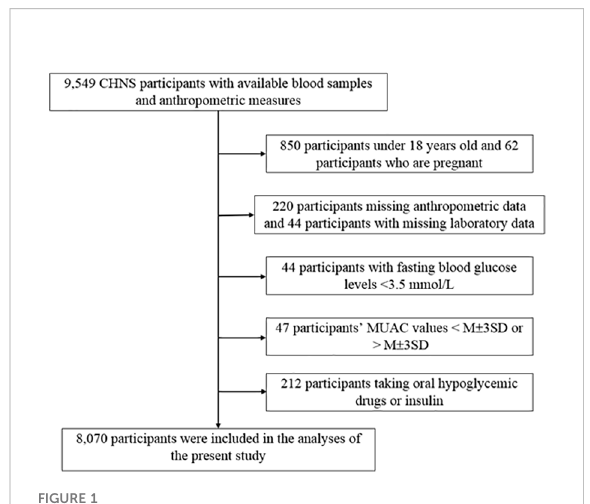
FIGURE 1 Flowchart of study participants. CHNS, the China Health and Nutrition Survey; MUAC, mid-upper arm circumference; M, mean; SD, Standard